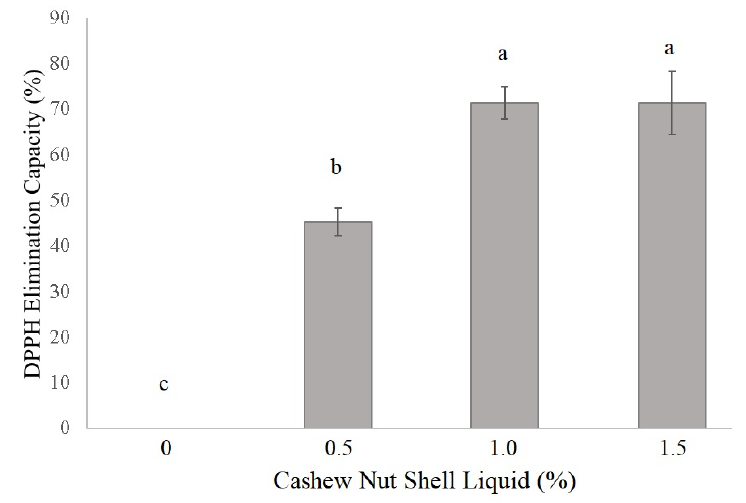
Figure 3. Antioxidant activity (elimination capacity of DPPH) of bioactive films obtained from the incorporation of cashew nut shell liquid (CNSL) into a matrix of sodium alginate. Mean ± standard deviation ( n = 3), a–c means followed by different lowercase letters differ by the Tukey test ( p < 0.05).